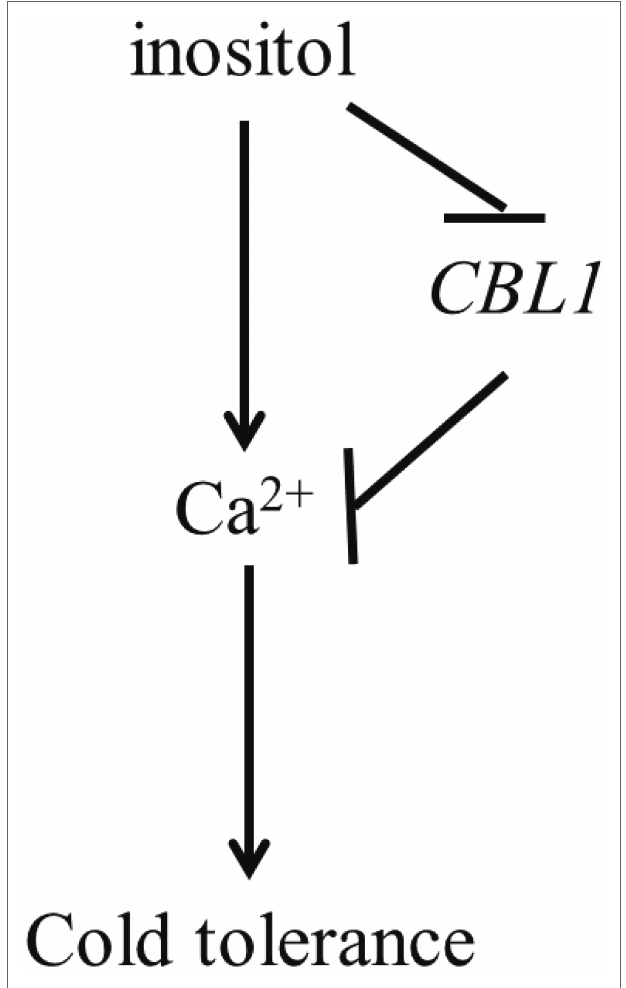
FIGURE 6 | The model of pathway of inositol, CBL1 and Ca 2+ response to cold stress. Arrows were represented positive regulation, whereas lines ending with a bar showed negative